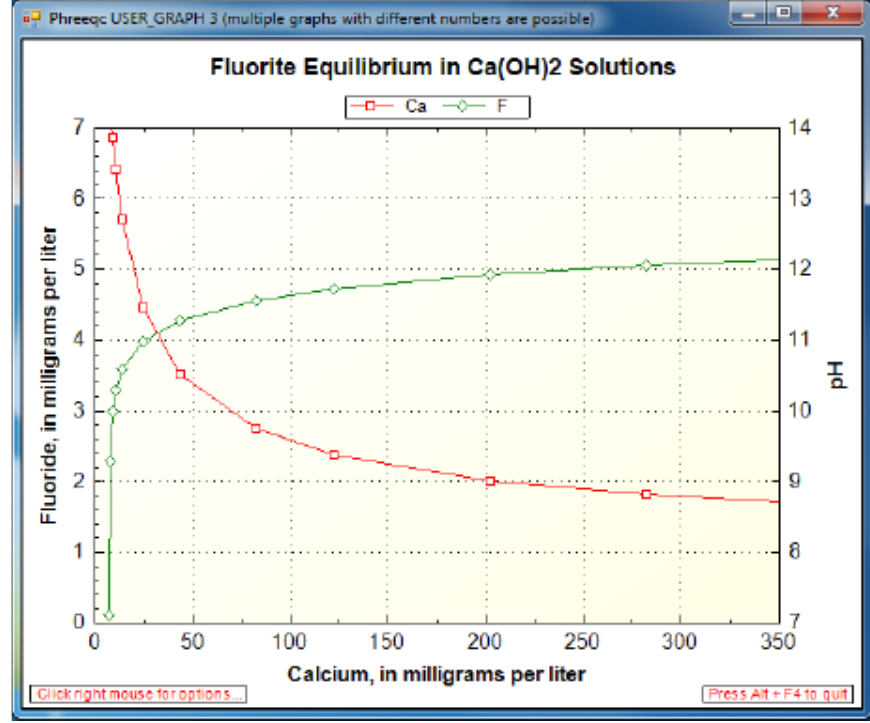
Figure 1. Chart from Example data block 1 plotting fluoride concentration and pH against calcium concentration for calcium hydroxide solutions in equilib- rium with